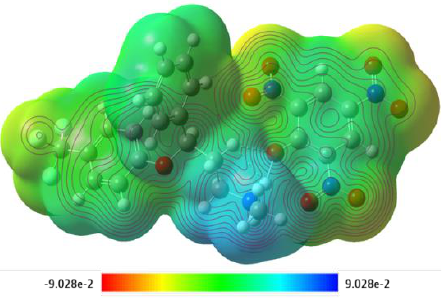
Figure 16. Molecular electrostatic potential surface map of [(FXN)(PA)] complex with respective color scales.